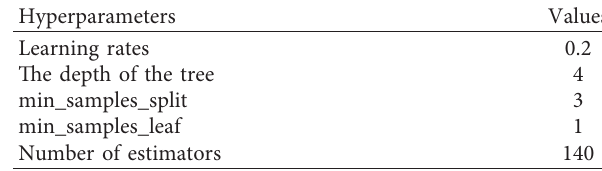
Table 6: Hyperparameters value of the GBRT